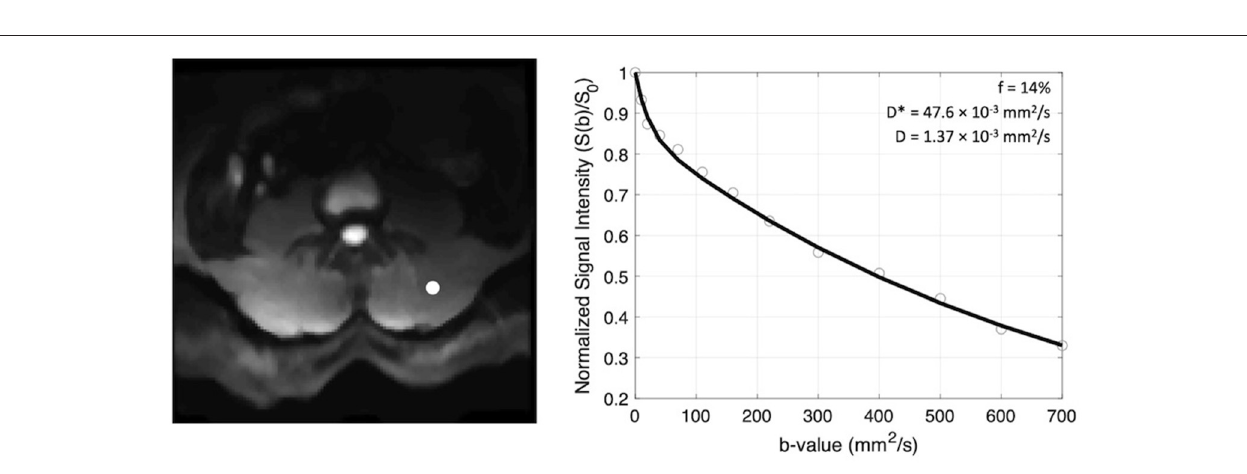
FIGURE 3 | Example of signal decay as a function of b-value (right) shown for the voxel indicated by the white circle on the left panel. The normalized signal intensity data are fit to a bi-exponential function and coefficients f, D*, and D are recorded.